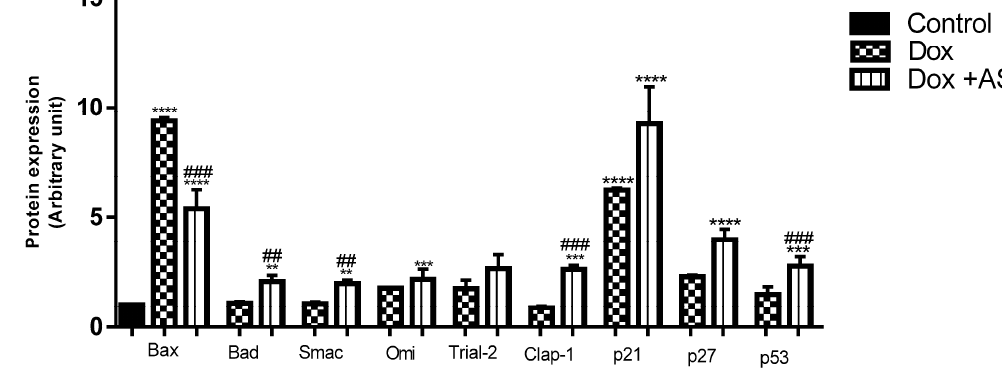
Figure 6. The effect of aspalathin (ASP) on pro-apoptotic protein expression in Caov-3 cells. Caov-3 ovarian cancer cells were treated with 0.2 µM Dox alone or in combination with 0.2 µM ASP daily for 5 days. Control samples were exposed to media only or ASP. Results are expressed as the mean ± SEM of three independent biological experiments, each with three technical replicates ( n = 9). ** p ≤ 0.01, *** p ≤ 0.001 and **** p ≤ 0.0001 versus control and ## p ≤ 0.01, and ### p ≤ 0.001 versus Dox.